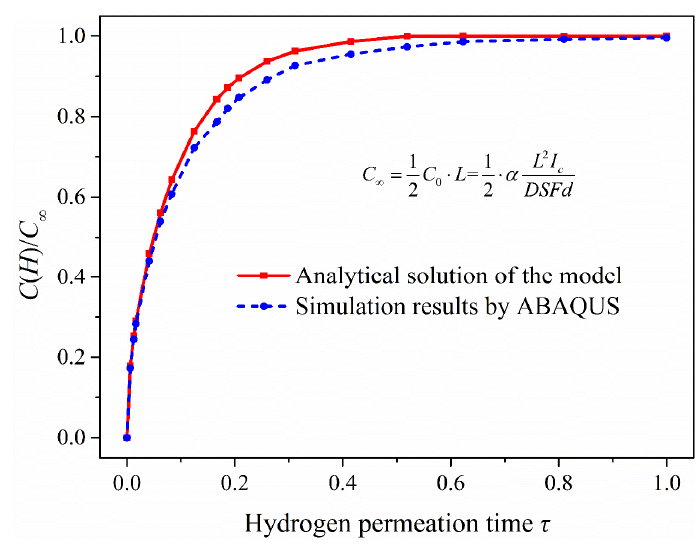
Figure 9. Hydrogen concentration distribution under different permeation time: ( a ) Finite element simulation results of the hydrogen permeation model; ( b ) Comparison of the analytical solution of the hydrogen permeation model and the simulation results.